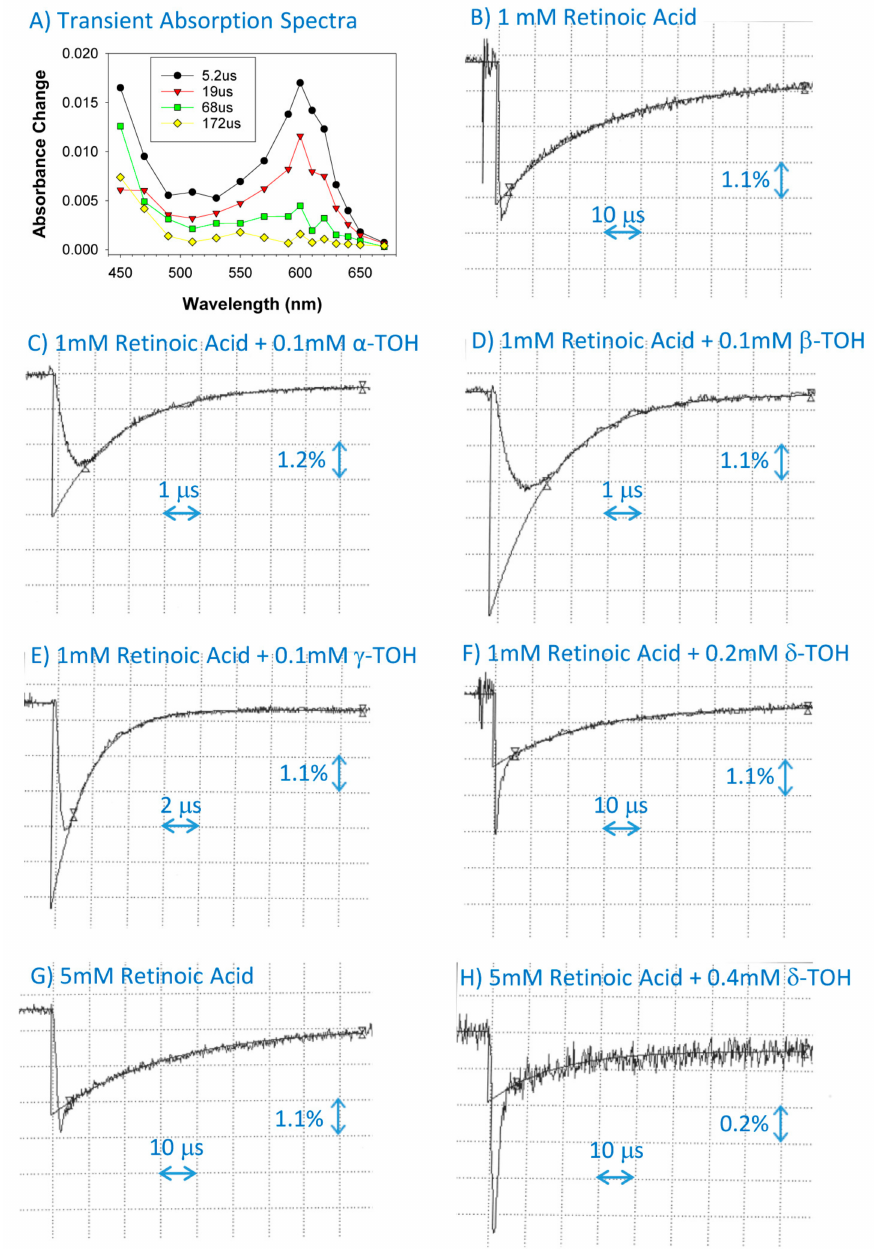
Figure 3. Transient absorption spectra at indicated times after pulse radiolysis of N 2 O-saturated benzene with 1 mM of solubilized retinoic acid ( A ), and representative kinetics monitored at 600 nm ( B – H ) of the formation and decay of retinoic acid cation radicals after pulse radiolysis in the absence and presence of α -tocopherol ( α -TOH), β -tocopherol ( β -TOH), γ -tocopherol ( γ -TOH), and δ -tocopherol ( δ -TOH). Trolox scavenged the cation radicals of retinoic acid with the bimolecular rate constant of − 1 · − 1 3.6 × 10 8 M s , which is 13 to 16 times less e ffi cient than α -, β -, and γ -tocopherols, but 13 times faster than δ -tocopherol (Figure 4; Table 1). The urate scavenged retinoic acid cation radicals with the − 1 · − 1 bimolecular rate constant of 7.8 × 10 8 M s , which is 2.2-fold more e ffi cient than the interaction with Trolox (Figure 4; Table 1), and slightly more e ffi cient than with ascorbate, for which the rate of − 1 · − 1 scavenging is 6.5 × 10 8 M s